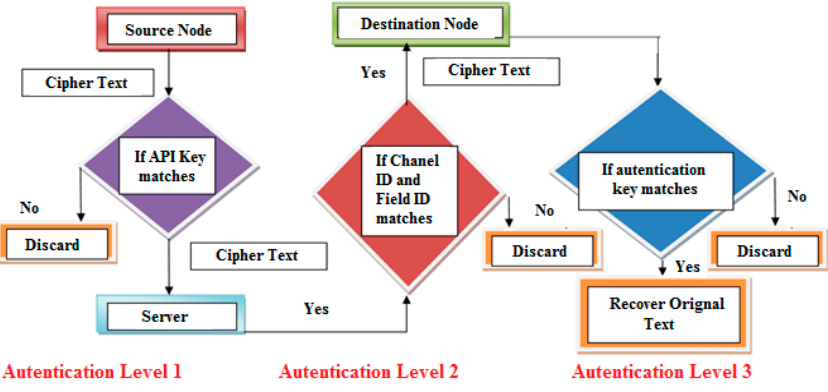
Figure 6. Three-levels of network security for IoT-based systems.